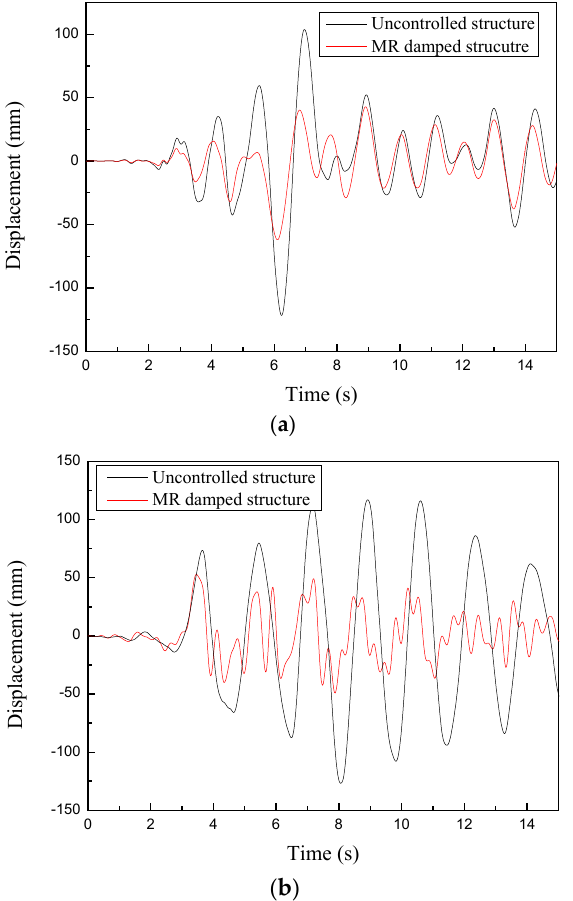
Figure 13. Displacement time history responses of the uncontrolled and MR damped structure. ( a ) El Centro. ( b ) Taft.